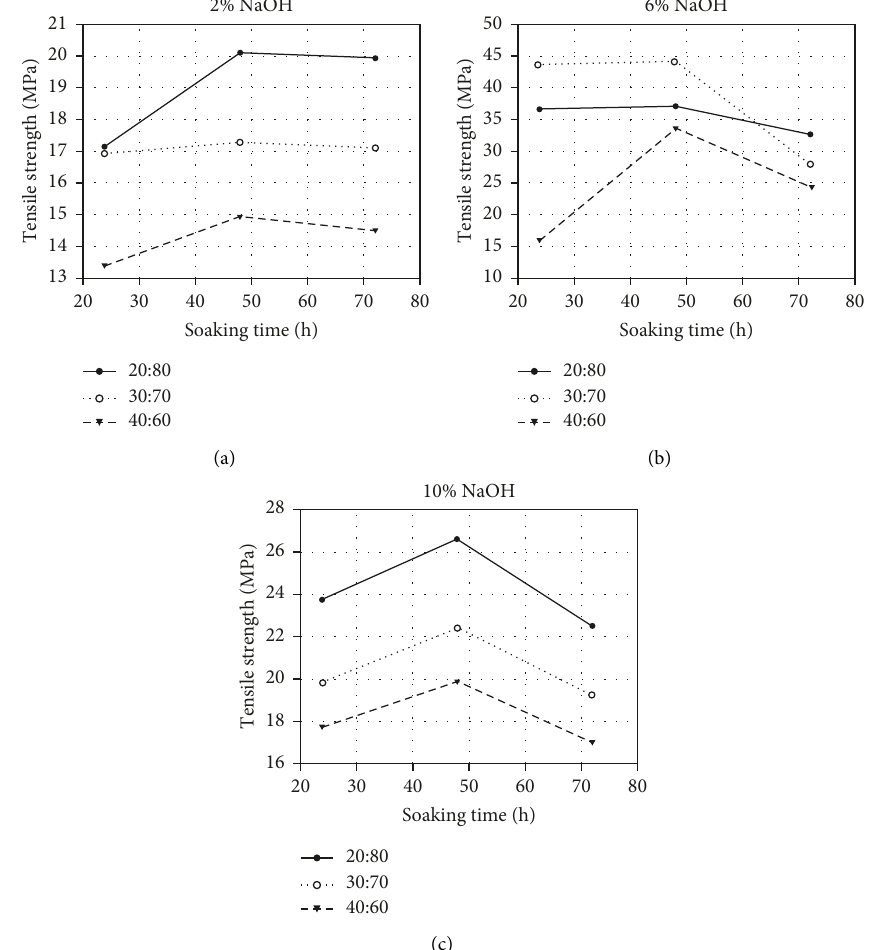
Figure 4: Effect of fiber to polyester ratio on tensile strength of composites: (a) 2%, (b) 6%, and (c) 10%